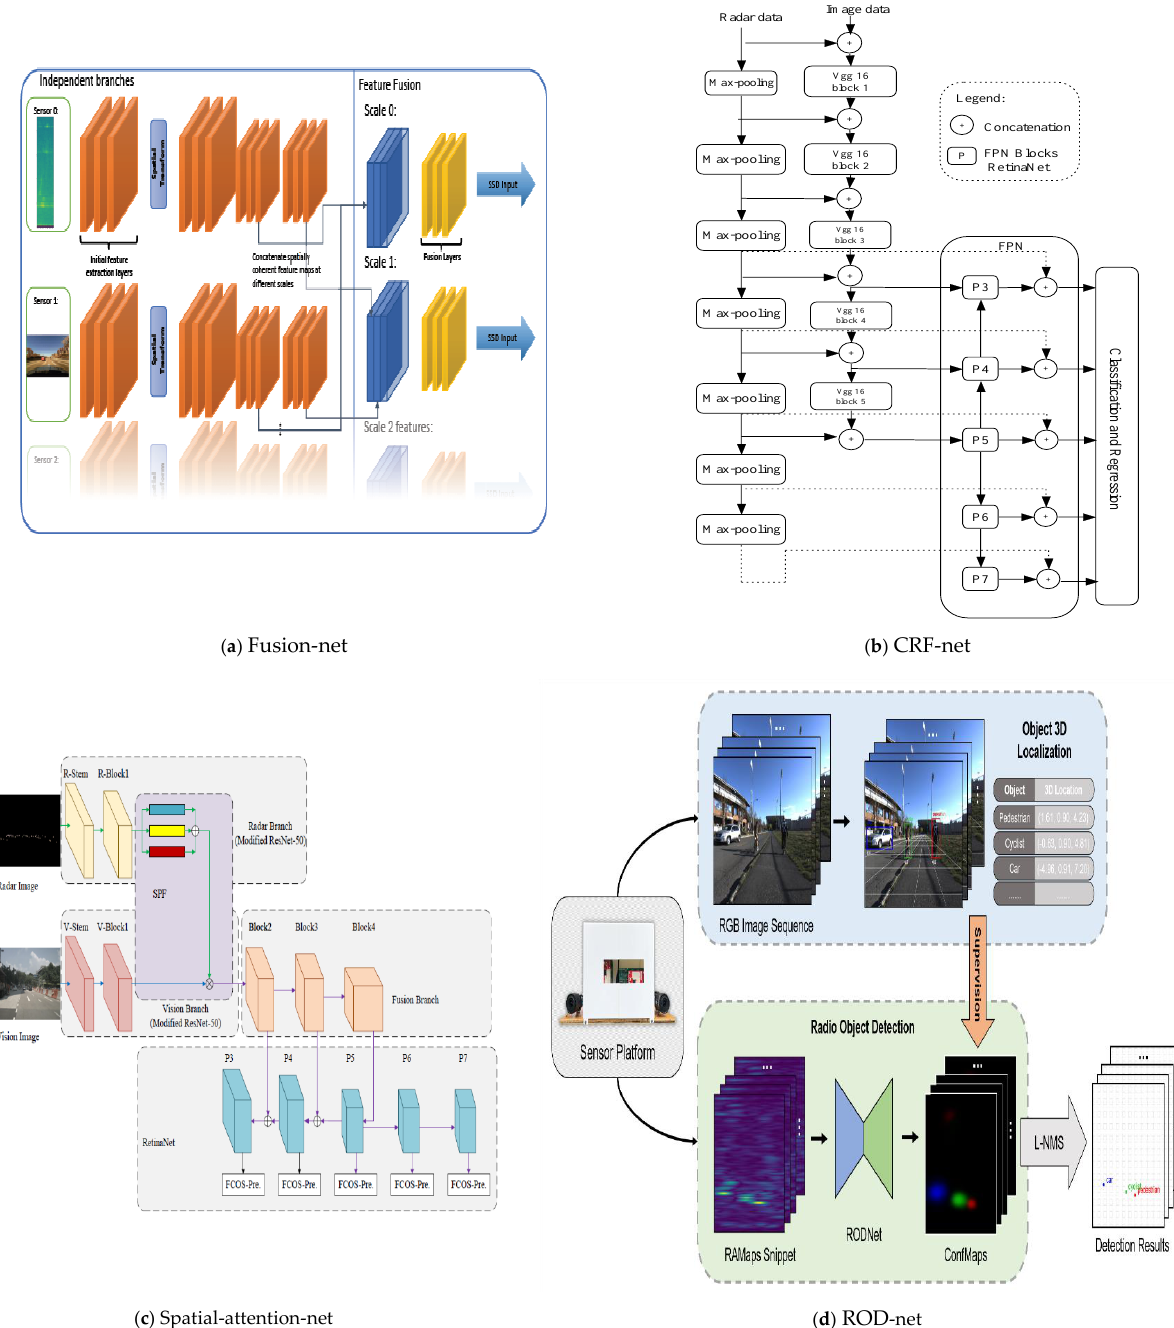
Figure 11. Example of some of the recent deep learning-based fusion architectures exploiting radar and camera data for object detection. ( a ) Fusion-net [53], ( b ) CRF-net [55], ( c ) Spatial fusion-net [58], and ( d ) ROD-net [98].